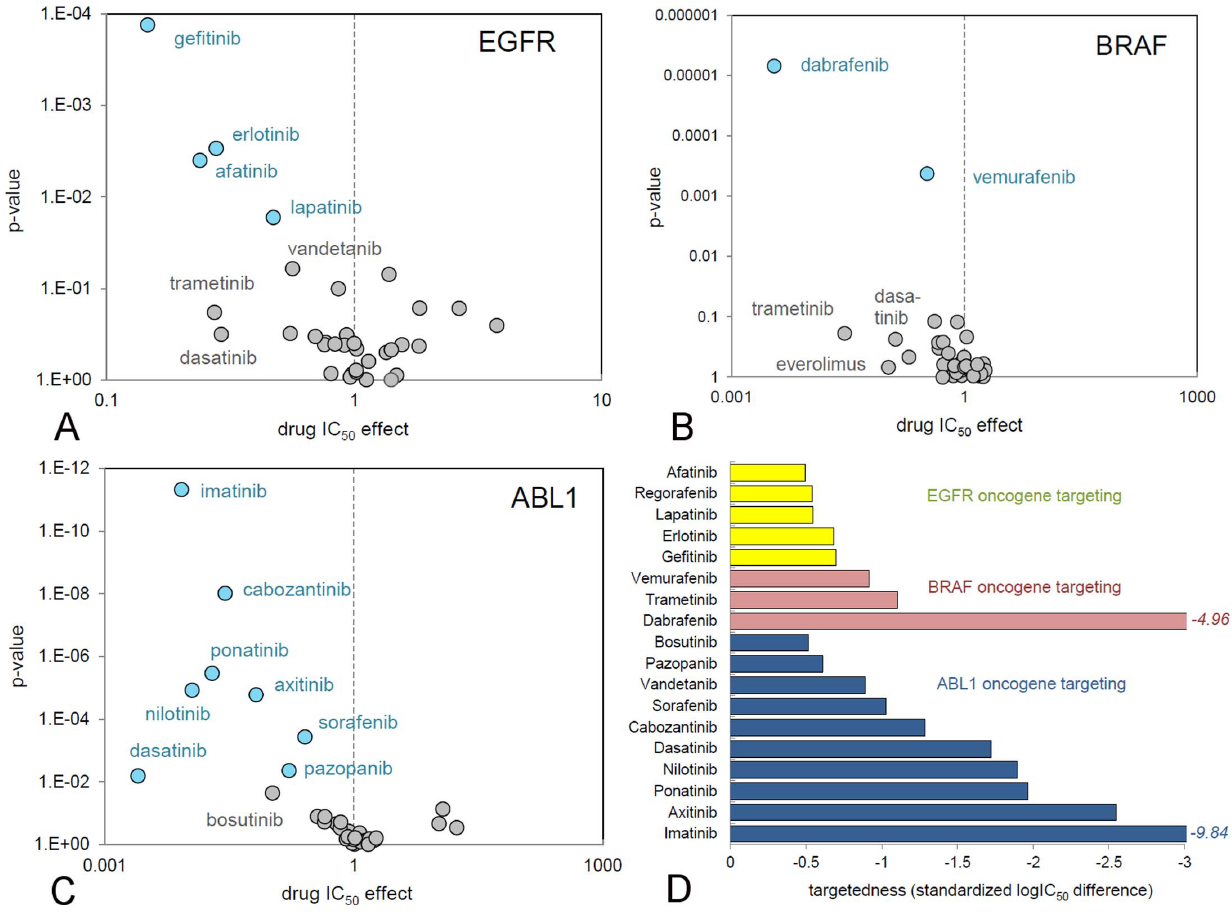
Figure 5. Comparison of the targeting efficacy of marketed inhibitors. Each circle represents a marketed kinase inhibitor and its targeted cell growth inhibition. A: Cell lines that overexpress EGFR . B: Cell lines containing the BRAF(V600E) mutation. C: Cell lines containing aberrant ABL1 signalling. Compounds in the upper left corner of the plots have superior targeting. Statistically relevant associations after correction for multiple testing are coloured blue. D: Quantitative comparison of inhibitor targeting by standardization of IC 50 shifts between sensitive and non-sensitive cell lines.